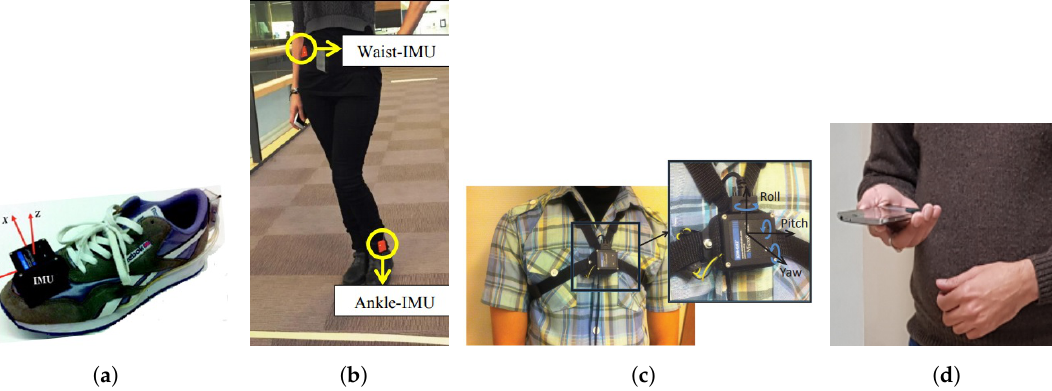
Figure 5. Examples of IMU placement, ( a ) foot mounted [44], ( b ) waist and ankel mounted [59], ( c ) chest hung [60], and ( d ) smartphone